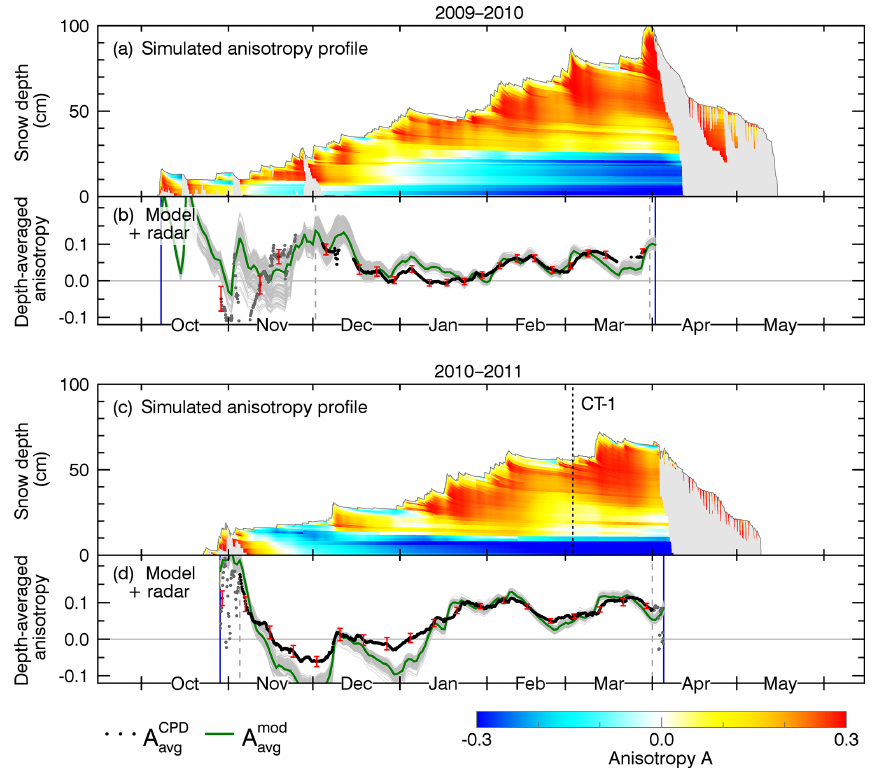
Figure 6. Structural anisotropy simulated for the first two seasons 2009/2010 and 2010/2011. (a, c) Depth-resolved anisotropy (in color) based on post-processed SNOWPACK data with model parameters α 1 = 1 . 01m 2 kg − 1 , α 2 = 1 . 68, A min = − 0 . 7, and A max = 0 . 3. Wet snow is grayed out. The sampling date of the validation profile CT-1 is indicated by the dashed line. (b, d) Modeled, depth-averaged anisotropy A mod avg (green: ensemble median; gray: ensemble members) and radar-measured anisotropy A CPD avg used for calibration of α 2 (black). Gray dots indicate radar measurements excluded from calibration because of a too big standard deviation (red error bars).